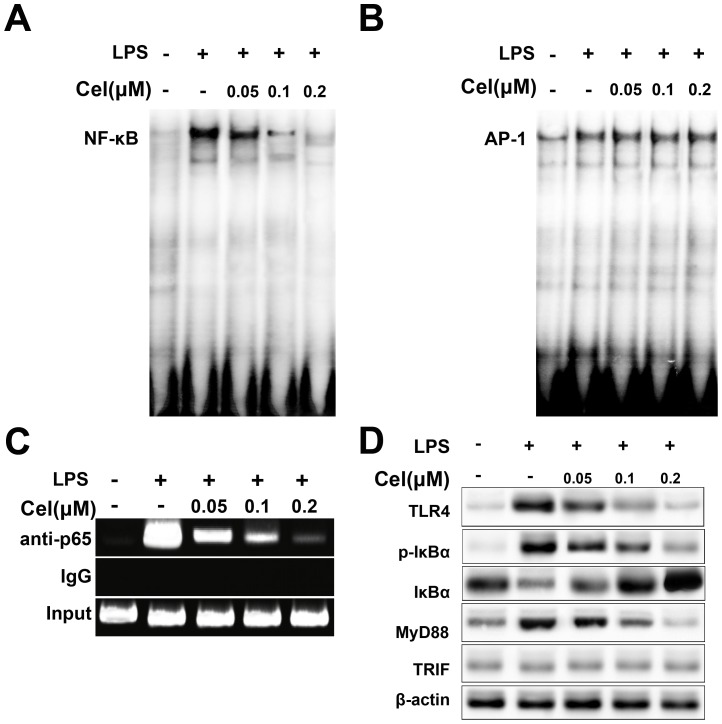
Celastrol inhibits the binding activity of NF-κB in the MMP-9 promoter.FLSs were pretreated with the indicated amounts of celastrol for 24 h and stimulated with LPS (1 µg/mL) for 24 h. A and B: The DNA binding activity of nuclear extracts was examined by EMSA using a probe containing the NF-κB and AP-1 motif in the MMP-9 promoter. NF-κB and AP-1 DNA binding activities were analyzed by EMSA and a representative blot from three independent experiments is shown. C: The cross-linked chromatin was prepared and immunoprecipitated with antibody and IgG to NF-κB p65 before amplification of the MMP-9 gene region containing the NF-κB site. Immunoprecipitates were analyzed by PCR for the presence of the MMP-9 gene promoter sequence using the primer pair previously described and DNA purified from the sonicated chromatin was directly analyzed by PCR using the same primer set, which served as an input control (Input). Similar results were obtained in three independent experiments. D: FLSs were harvested and whole cell extracts were subjected to western blot analysis for the indicated proteins (IκBα, p-IκBα, TLR4, MyD88 and TRIF). A representative protein blot of three independent experiments is shown. β-Actin served as a control.